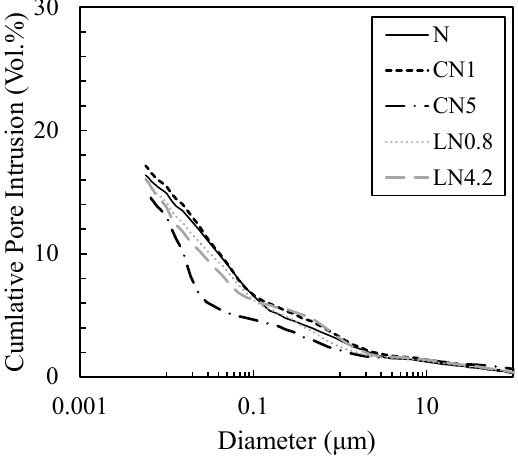
Figure 13. Void size distribution (7 days).